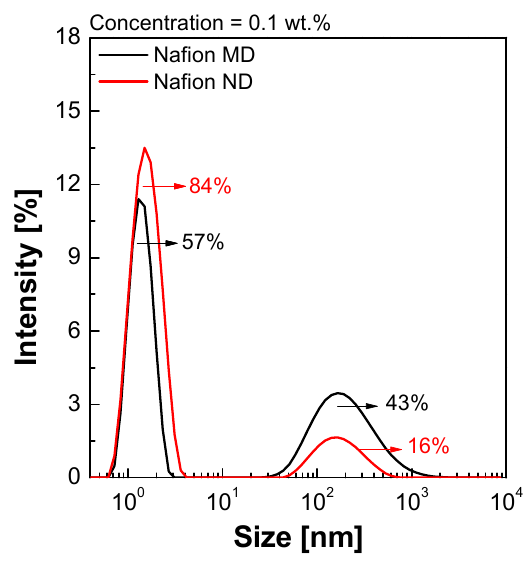
Figure 3. Particle size distribution pattern of Nafion ionomers by DLS.